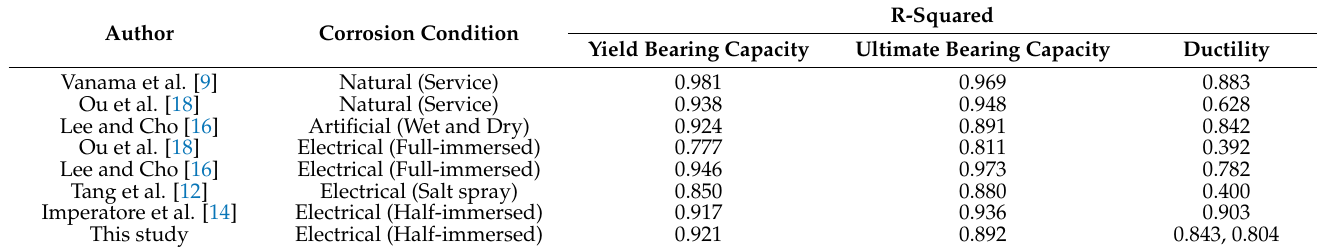
Table 5. Summary of correlation between mechanical characteristics and average corrosion